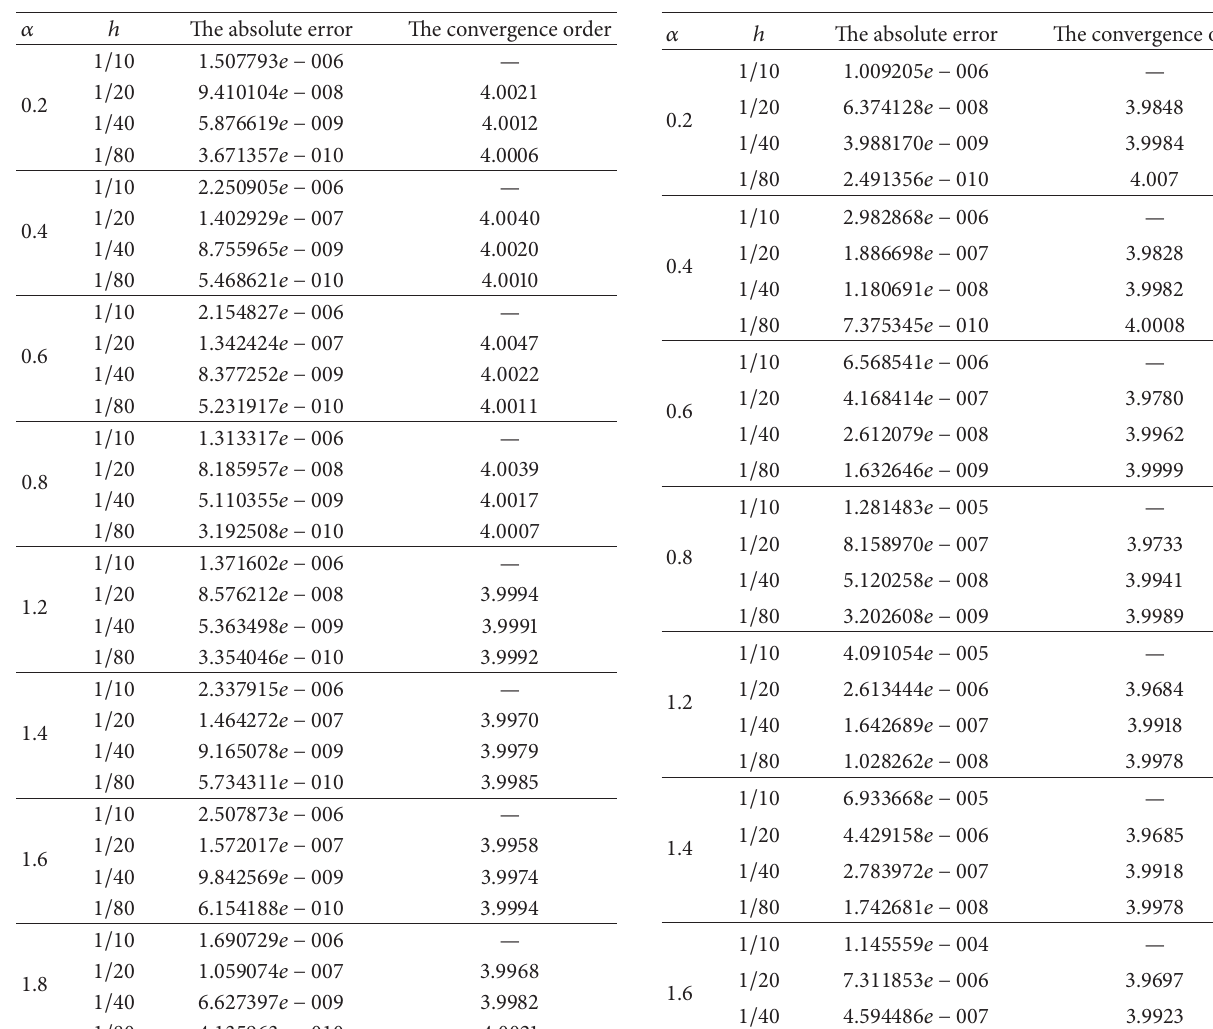
Table 1: The numerical results of Example 6 by difference Scheme (7).